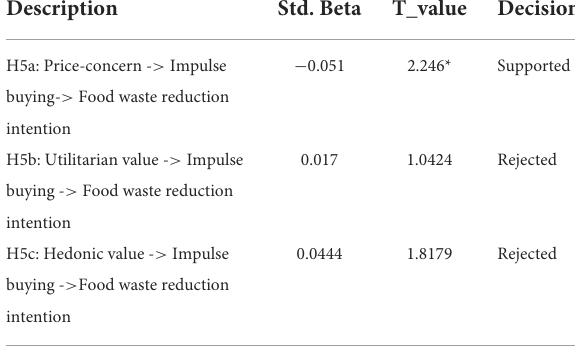
TABLE 4 Path coefficients of the structural model. TABLE 5 Results of mediation analysis.